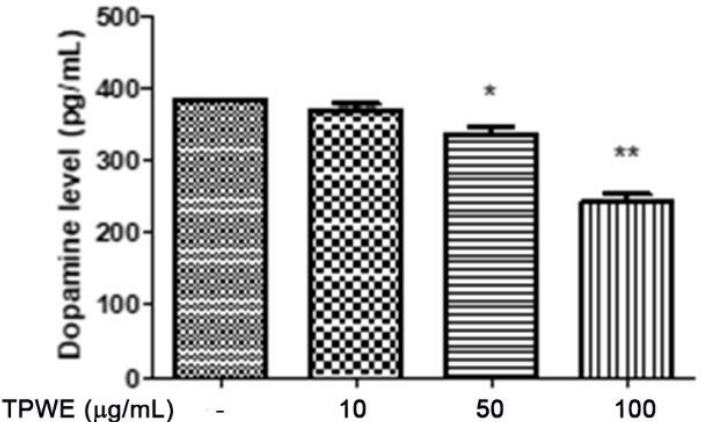
Figure 9. The inhibitory effect induced by Tanacetum parthenium (TPWE: 10–100 µ g/mL) on dopamine release (pg/mL) from hypothalamic HypoE22 cells. ANOVA, p < 0.001; * p < 0.05, ** p < 0.01 vs. the untreated control (CTR) group.